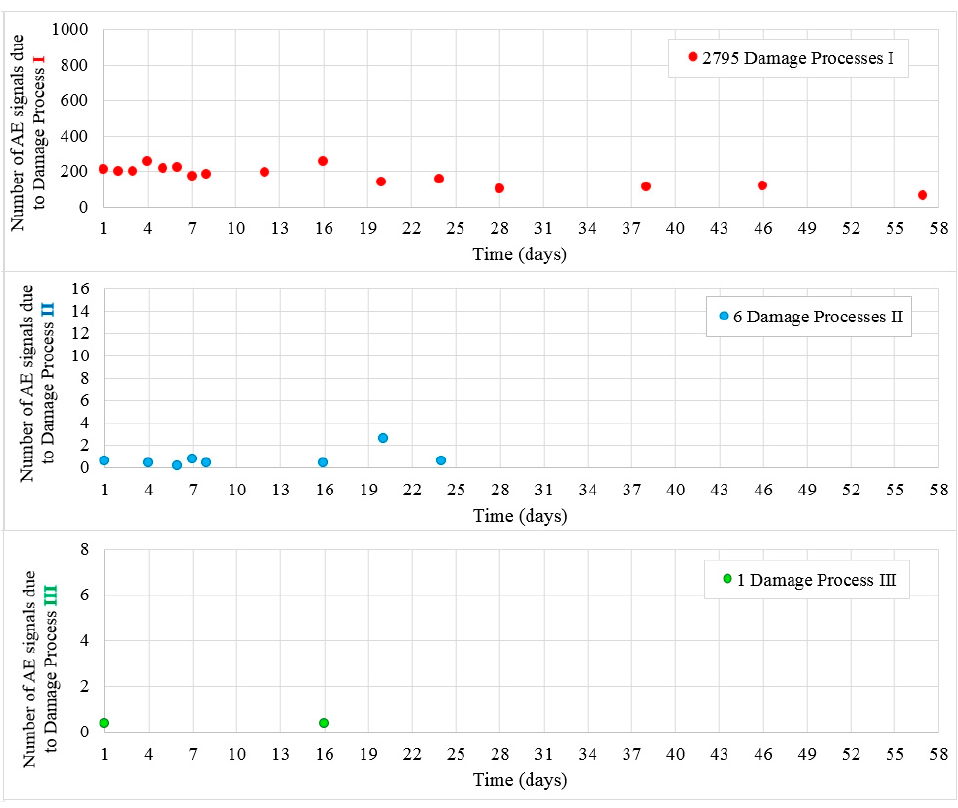
Figure 10. Number of damage processes I–III obtained from W7 samples.